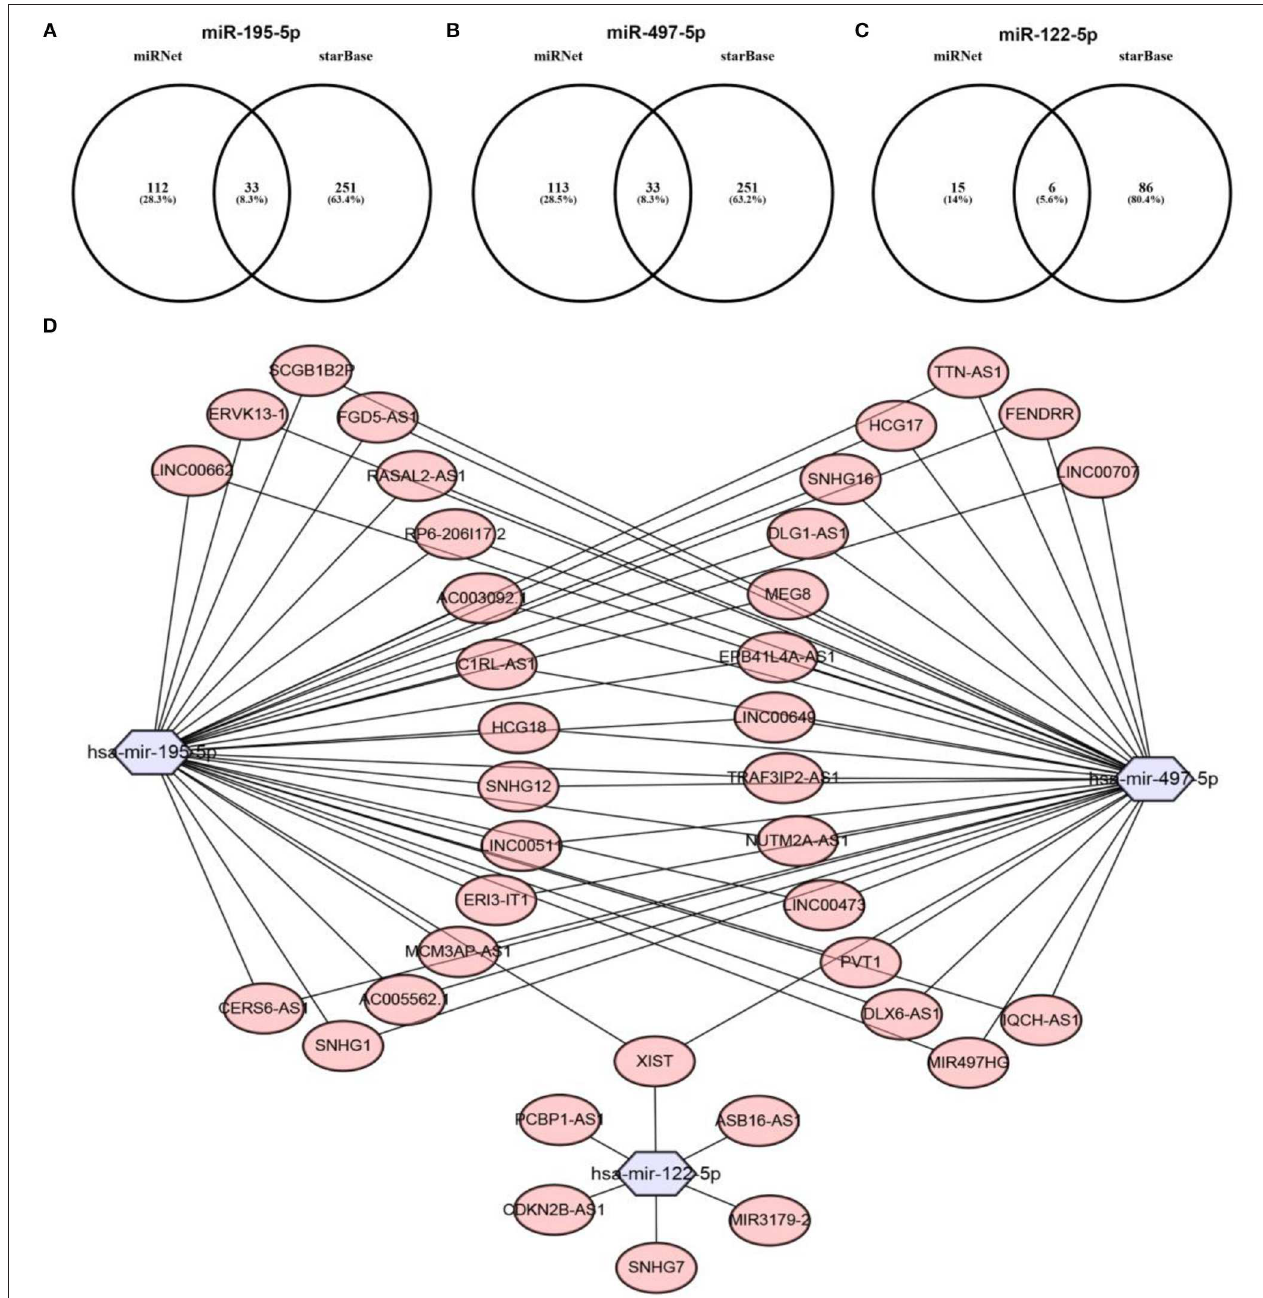
FIGURE 6 | Prediction of upstream lncRNAs potentially binding to hsa-mir-195-5p, hsa-mir-497-5p, and hsa-mir-122-5p. (A) Potential lncRNAs of hsa-mir-195-5p predicted by miRNet and starBase databases; (B) potential lncRNAs of hsa-mir-497-5p predicted by miRNet and starBase databases; (C) potential lncRNAs of hsa-mir-122-5p predicted by miRNet and starBase databases; (D) establishment of miRNA-lncRNA network using Cytoscape software.